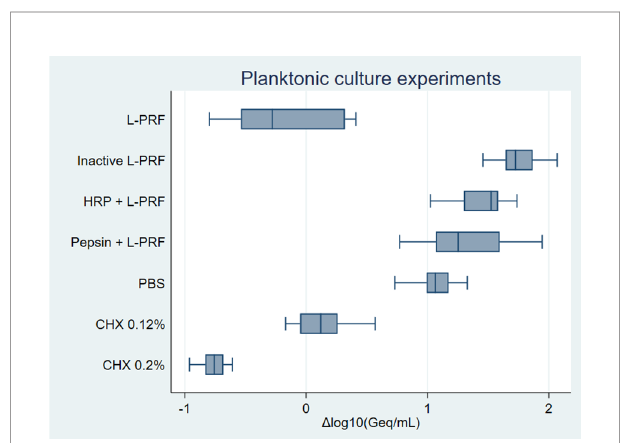
FIGURE 2 | Planktonic cultures experiments on P. gingivalis boxplot. Negative values represent bacterial growth inhibition while positive values indicate bacterial growth. D log 10 (Geq/mL), Differences in logarithmic values of genome equivalents per millilitre; L-PRF, leucocyte- and platelet rich fi brin; PBS, phosphate-buffered saline; CHX, Chlorhexidine; HRP, Horseradish peroxidase.